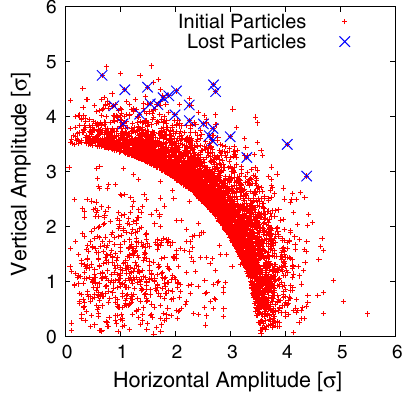
FIG. 17. Relative proton beam losses in 2 (cid:2) 10 6 turns for the proton bunch intensity 2 : 0 (cid:2) 10 11 . The losses without beam- beam compensation, with half beam-beam compensation, with the betatron phase advance adjustment, and with the global second order chromaticity correction ( (cid:9) ð 2 Þ corr.) are shown.